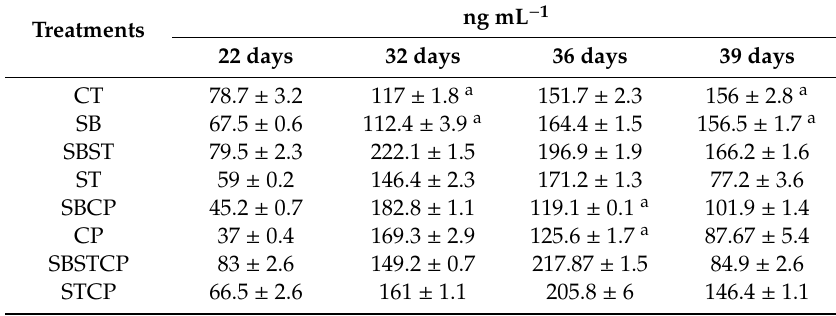
Table 7. Synbiotic e ff ect on serum IgA concentration in broilers challenged with Salmonella typhimurium and Clostridium perfringens (ng mL − 1 ) in di ff erent days of